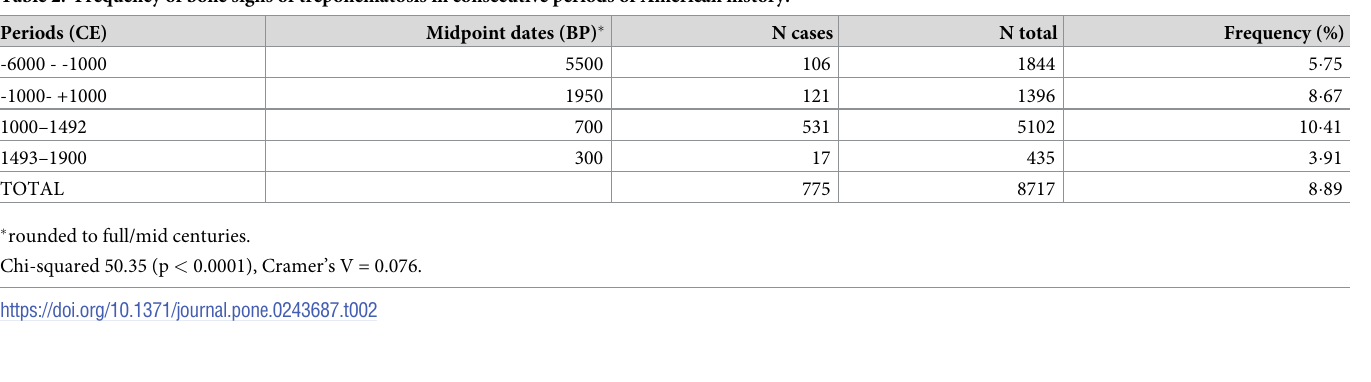
Table 2. Frequency of bone signs of treponematosis in consecutive periods of American history. Periods (CE)